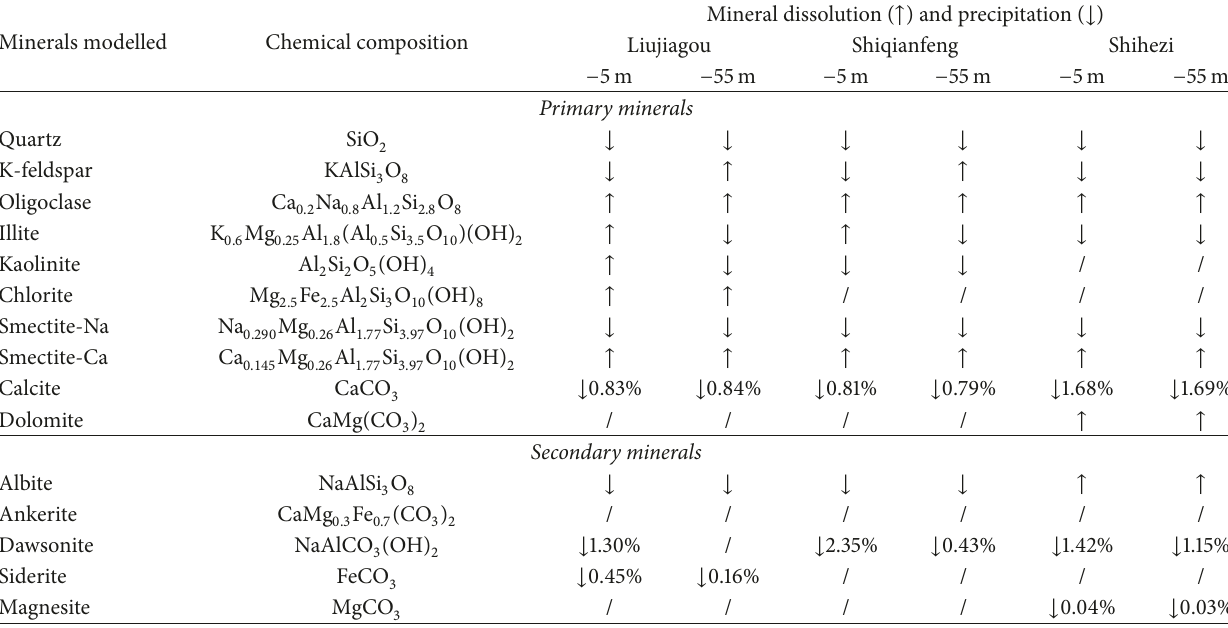
Table 5: The changes in abundance of mineral dissolution and precipitation after 10,000 years. Mineral dissolution ( ↑ ) and precipitation ( ↓ ) Minerals modelled Chemical composition Primary minerals